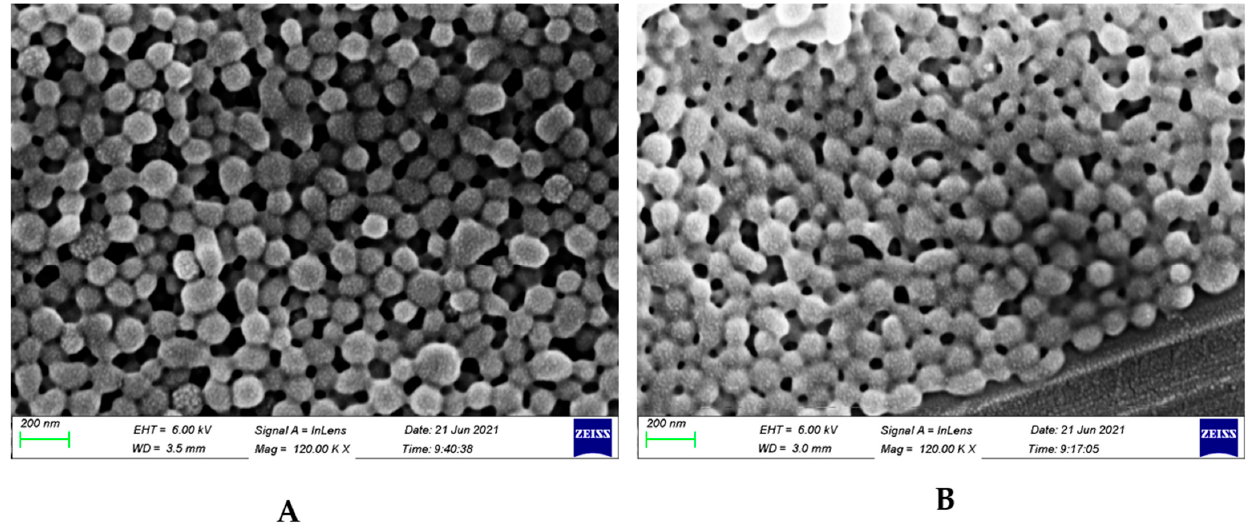
Figure 4. Scanning electron micrographs of ( A ) uncoated nanoparticles and ( B ) coated nanoparticles.